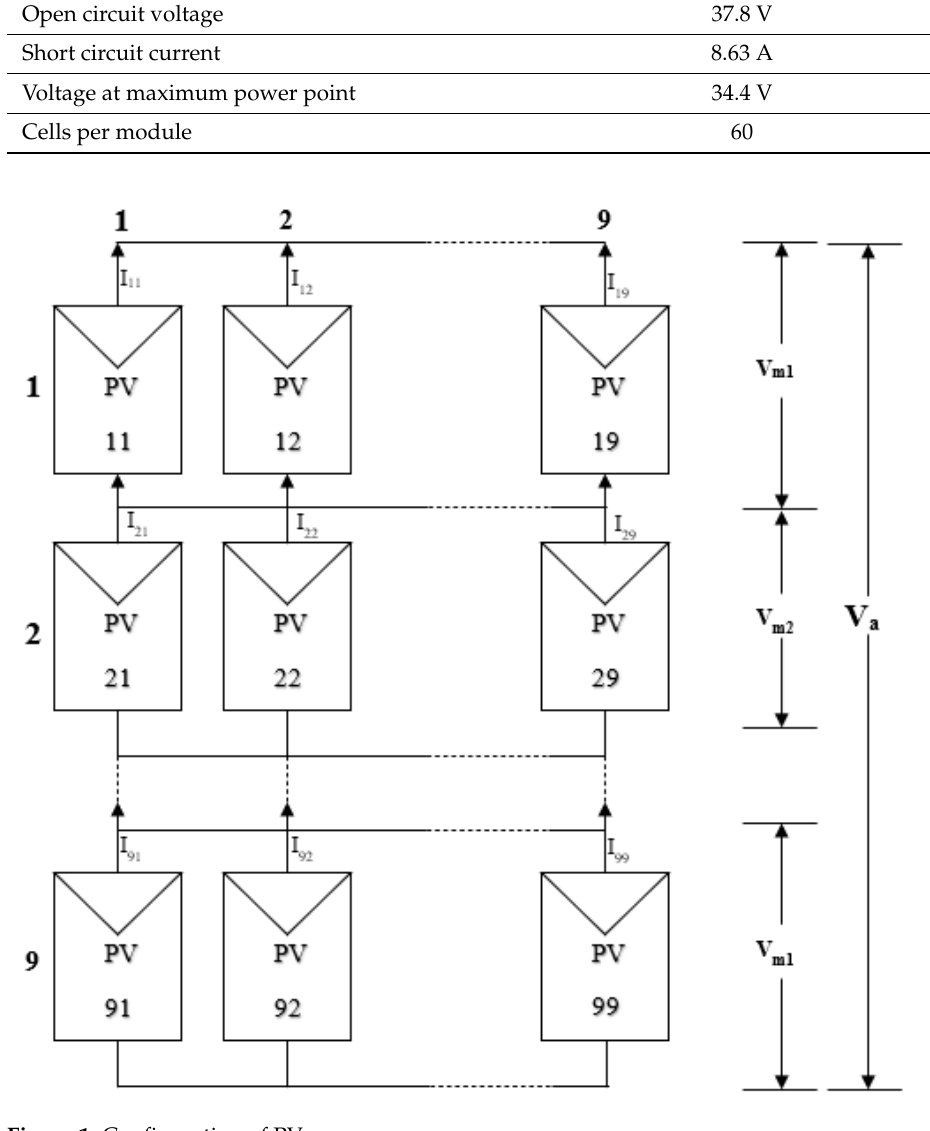
Figure 1. Configuration of PV array.